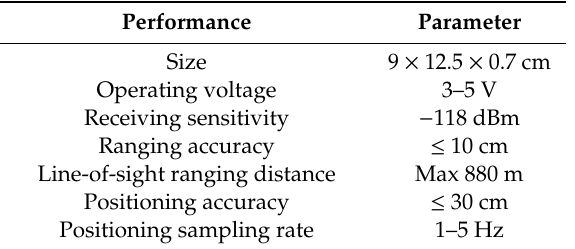
Table 2. Performance of the UWB anchor and tag two-in-one device